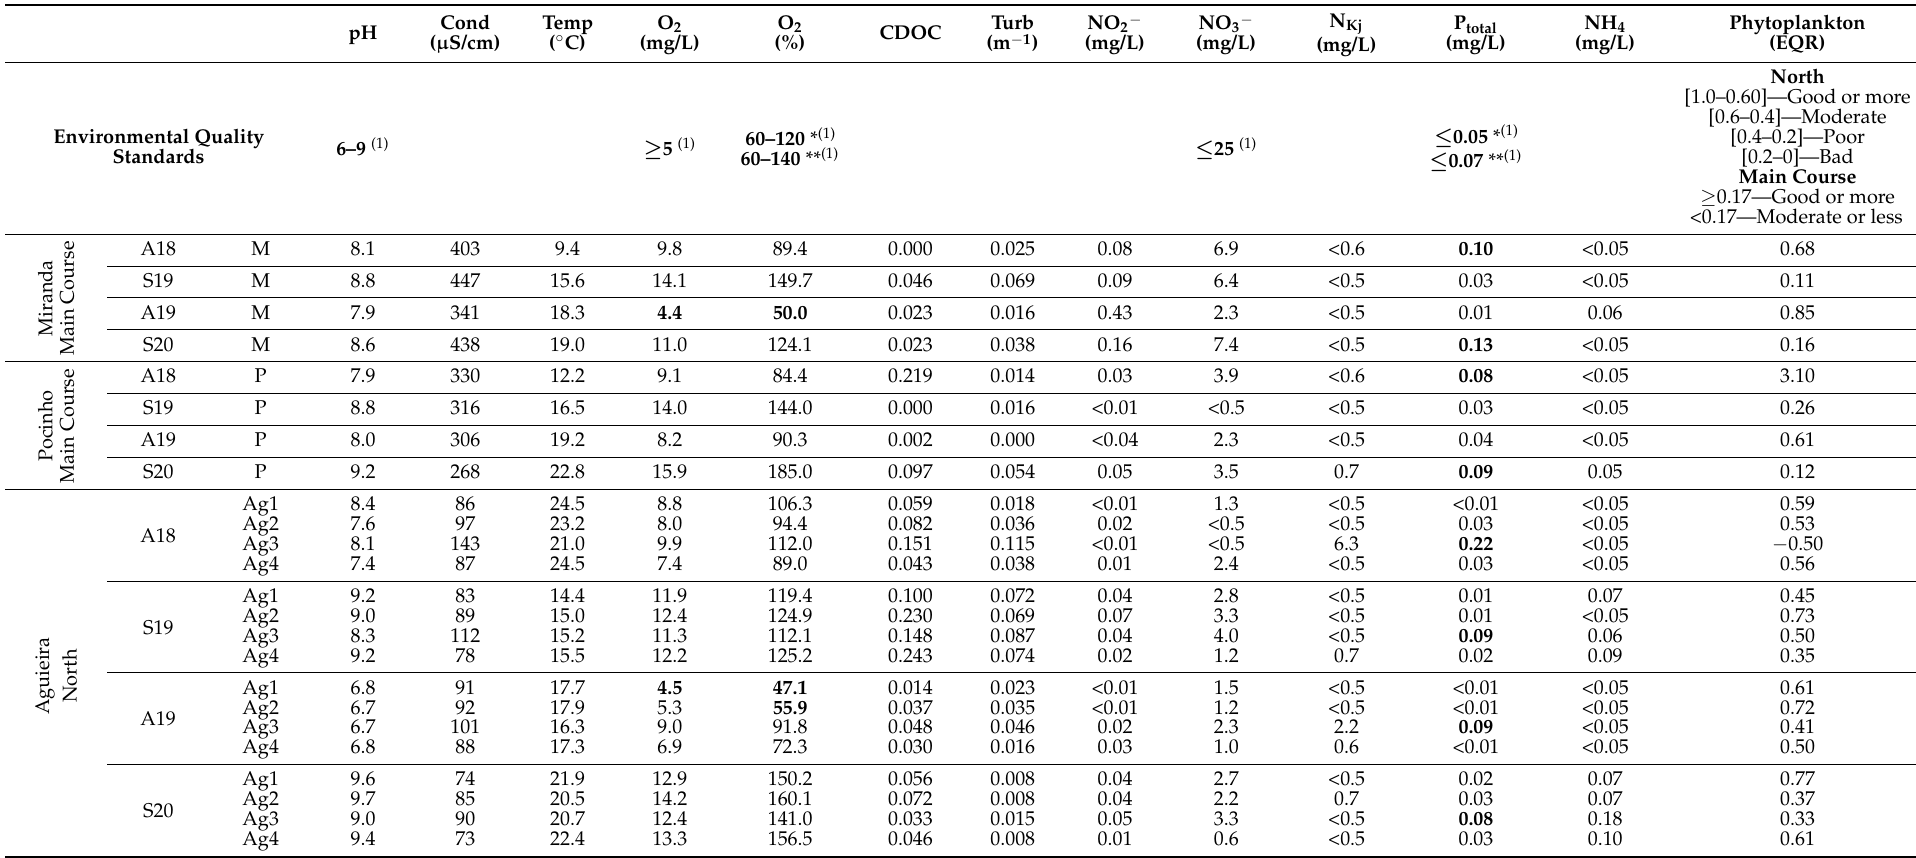
Table 1. Physical and chemical parameters (FQ): pH, conductivity (Cond), temperature (Temp), dissolved oxygen (O 2 ) dissolved organic carbon (CDOC), turbidity (Turb), nitrites (NO 2 − ), nitrates (NO 3 − ), total Kjeldahl nitrogen (N Kj ), total phosphorus (P total ) and ammonium (NH 4 ); and the biological parameter (BIO): phytoplankton (Ecological Quality Ratio EQR) for each site and reservoir along the study periods. The highlighted values (in bold) represent the values outside the environmental quality standards. * stands for reference conditions in Miranda, Pocinho and Aguieira reservoirs; ** stands for reference conditions in Alqueva reservoir; (1) [49]. pH Cond ( µ